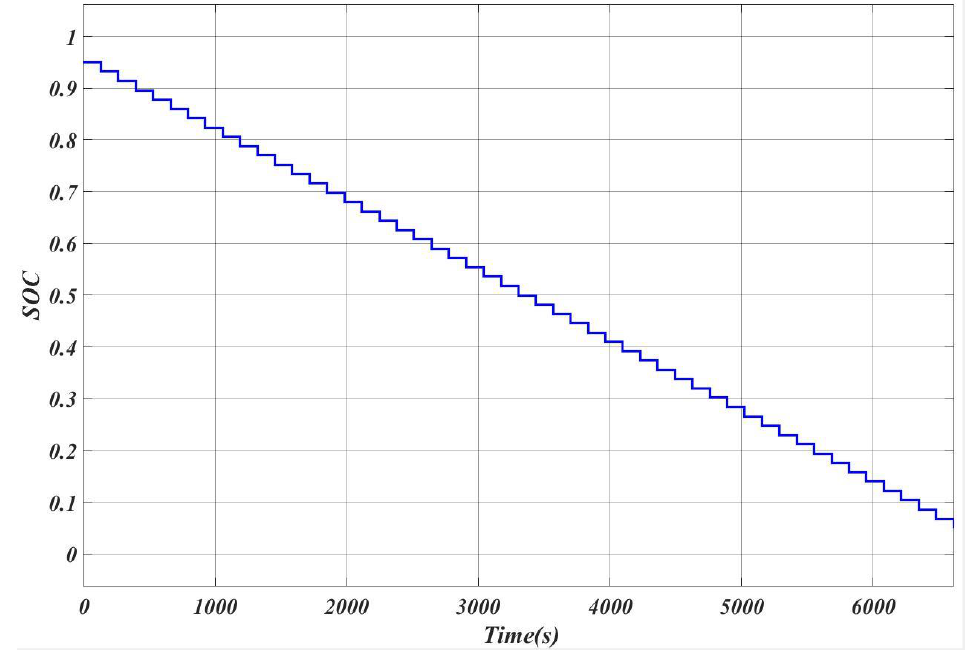
Figure 13. SOC vs. Time for reference discharge.